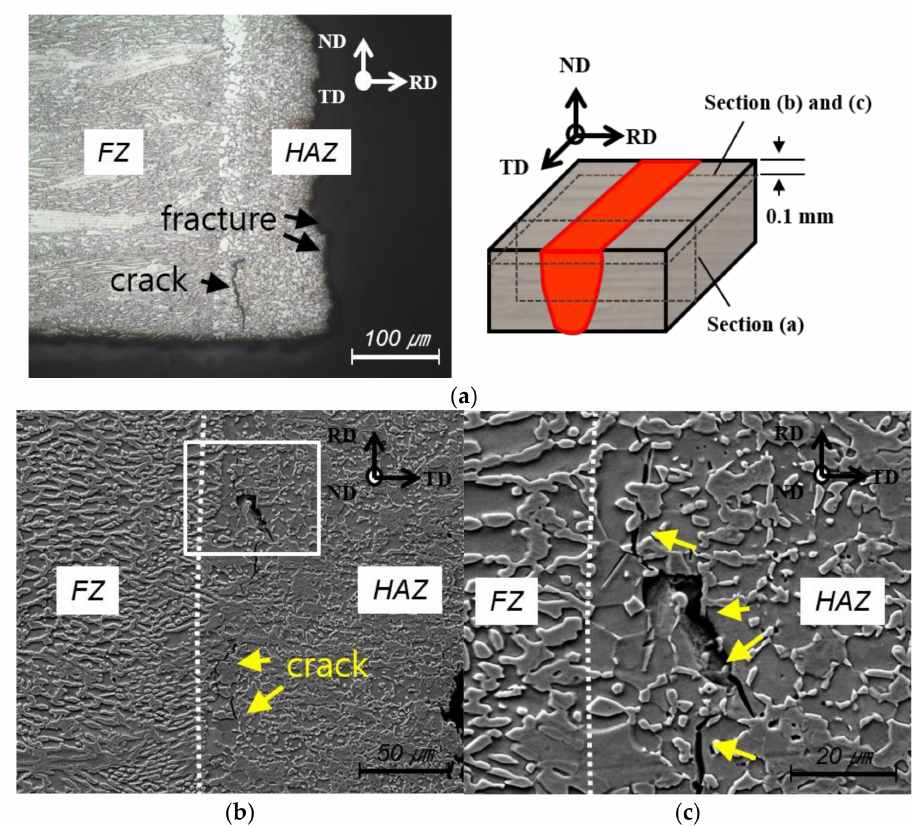
Figure 2. Micrographs of fracture section along the ( a ) transverse (magnification of 1000 × ) and ( b ) normal directions after the tensile test (magnification of 1000 × ), and ( c ) a normal direction view of the contents of the white-bordered box in ( b ) (magnification of 3000 × ). Specimen was prepared using a laser power of 4 kW and a welding speed of 10 m/min. FZ is the fusion zone; HAZ is the heat-affected